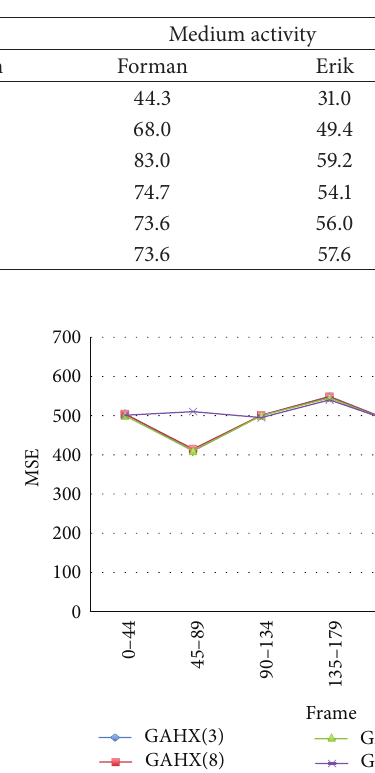
Table 1: Average MSE per block in various methods with different video sequences.